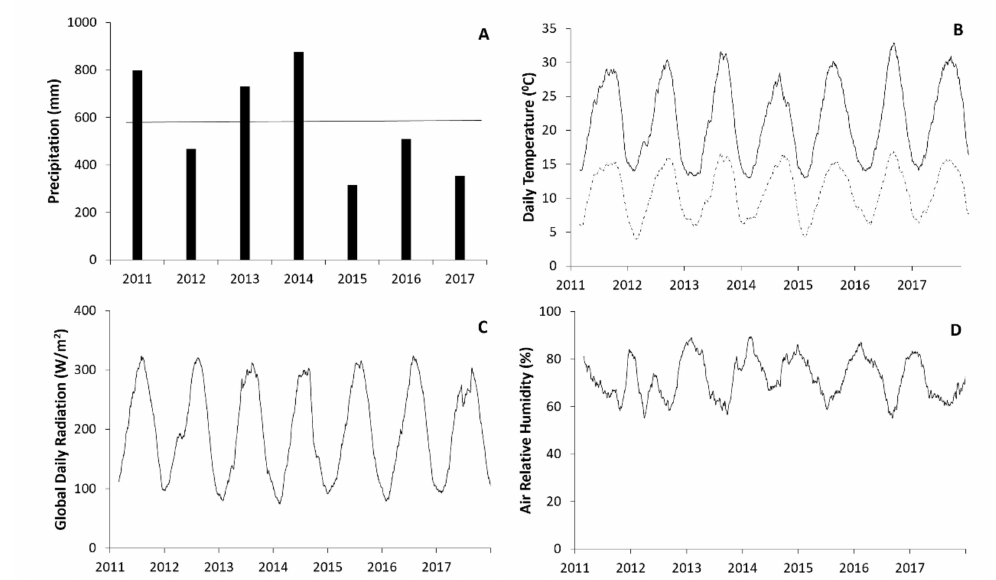
Figure 3. Time series of climatic variables observed from April 2011 to December 2017: ( A ) yearly total precipitation (mm), with mean annual precipitation represented by horizontal line (625 mm); ( B ) minimum (dashed lines) and maximum (solid lines) temperature ( ◦ C); ( C ) global daily radiation (W m − 2 ); ( D ) relative air humidity (%). Data for temperature, global radiation and relative humidity are presented with the moving average for a 60-day